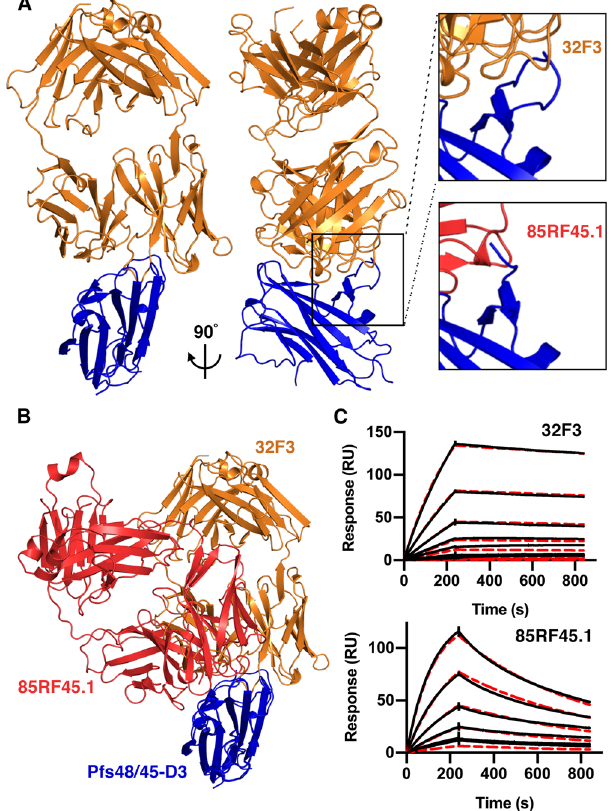
Fig. 1 | Comparison of the epitopes of transmission-blocking antibodies 85RF45.1 and 32F3. A The structure of the C-terminal domain of Pfs48/45 (Pfs48/ 45-D3;blue)boundtoantibody32F3(orange).Theupperrightinsetshowsaclose- up of a Pfs48/45 loop which becomes ordered on 32F3 binding. The lower inset showstheequivalentviewofthecomplexofPfs48/45-D3(blue)boundto85RF45.1 (red). B An alignment of the structures of 32F3 (orange) and 85RF45.1 (red) bound to Pfs48/45-D3 (blue). C Surface plasmon resonance analysis of the binding of Pfs48/45-D3 to immobilised 32F3 and 85RF45.1. In both cases, the black lines show the responses due to a two-fold dilution series with a top concentration of 7.8nM for 85RF45.1 and 125nM for 32F3. The red dashed lines show fi tting to a 1-to-1 binding